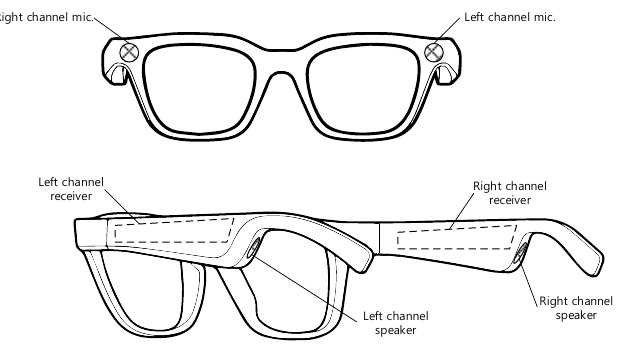
Figure 2. Receiver device in the shape of eyeglasses.